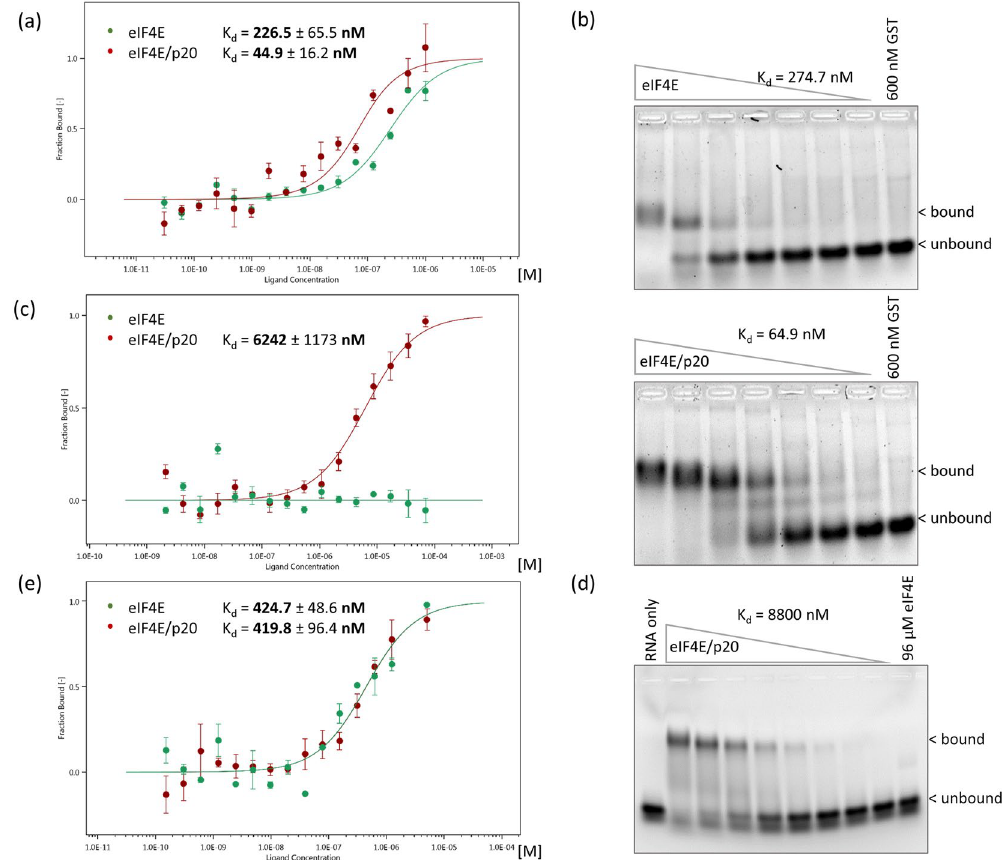
Figure 1. Determination of dissociation constants (K d ) for eIF4E/p20 complex or eIF4E bound to capped or uncapped RNA by MicroScale Thermophoresis (MST) and Electrophoretic Mobility Shift Assay (EMSA). ( a ) MST: 50 nM RED fluorescence dye-labeled His6x-eIF4E (green) or eIF4E/His6x-p20 complex (red) with serially diluted m 7 GpppG-capped 64 nt long RNA (40 nt of SSA1 5 ′ UTR), starting at 1 µ M. Error bars indicate s.d. (n = 3). ( b ) EMSA: 600–0 nM His6x-eIF4E or 600–0 nM eIF4E/His6x-p20 complex with 0.25 µ M m 7 GpppG- capped 64 nt long RNA (40 nt of SSA1 5 ′ UTR) probe. SYBR Gold Nucleic Acid Gel Stain. GST (Glutathione-S Transferase) serves as a negative control. ( c ) MST: Serially diluted His6x-eIF4E (green) or eIF4E/His6x-p20 complex (red), starting at 96 µ M, with 50 nM 3 ′ FAM-labeled uncapped 40 nt long 5 ′ UTR of SSA1 RNA. Error bars indicate s.d. (n = 3). ( d ) EMSA: 96–0 µ M eIF4E/His6x-p20 complex with 1 µ M 3 ′ FAM-labeled uncapped 40 nt long RNA probe (5 ′ UTR of SSA1). ( e ) MST: 50 nM RED fluorescence dye-labeled His6x-eIF4E (green)